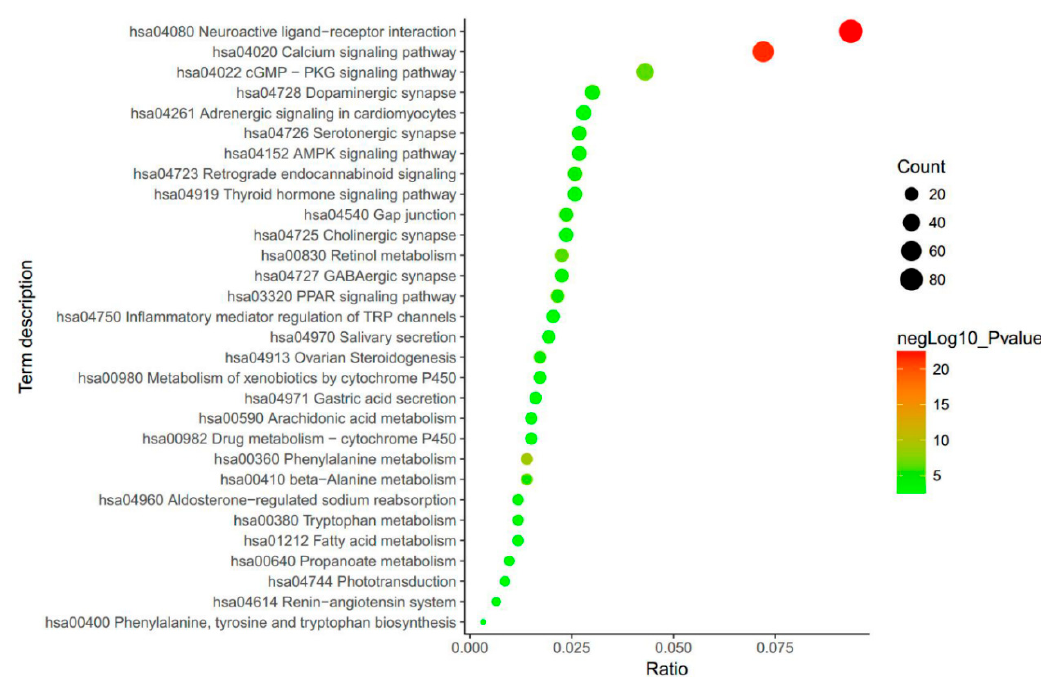
Figure 1. The biological mechanisms enrichment of Schisandra chinensis Fructus (SCF). The round represents the relationship between SCF and the biological terms. The size of the round signifies the count of the signaling pathways or functions. The color denotes the log10 of p value. The closer to red, the smaller p value is.